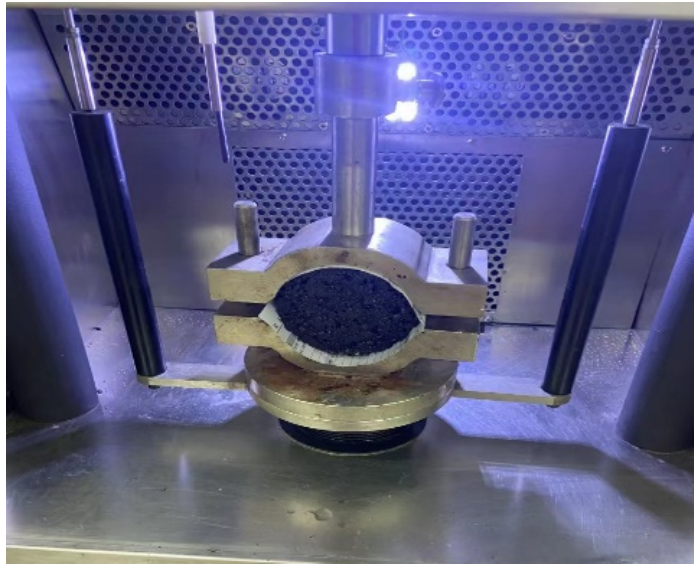
Figure 4. Multifunctional testing machine.